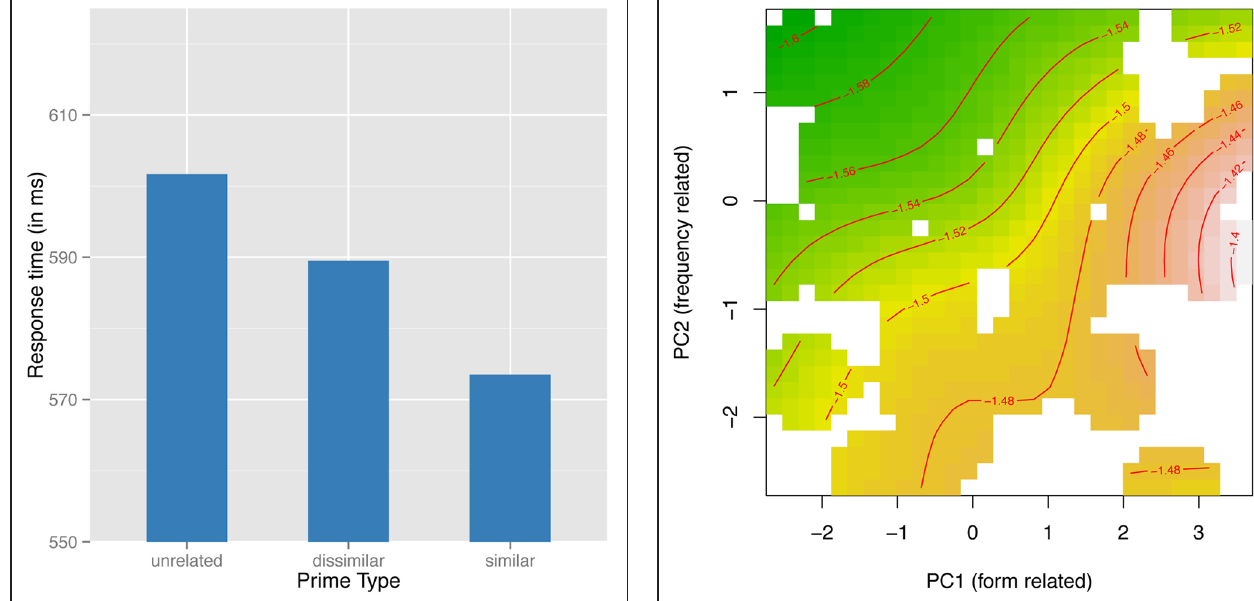
To probe for individual differences, we not only included two measures of reading skill (spelling proficiency and vocabulary), but also kept track of trial order, so as to maximize detection of